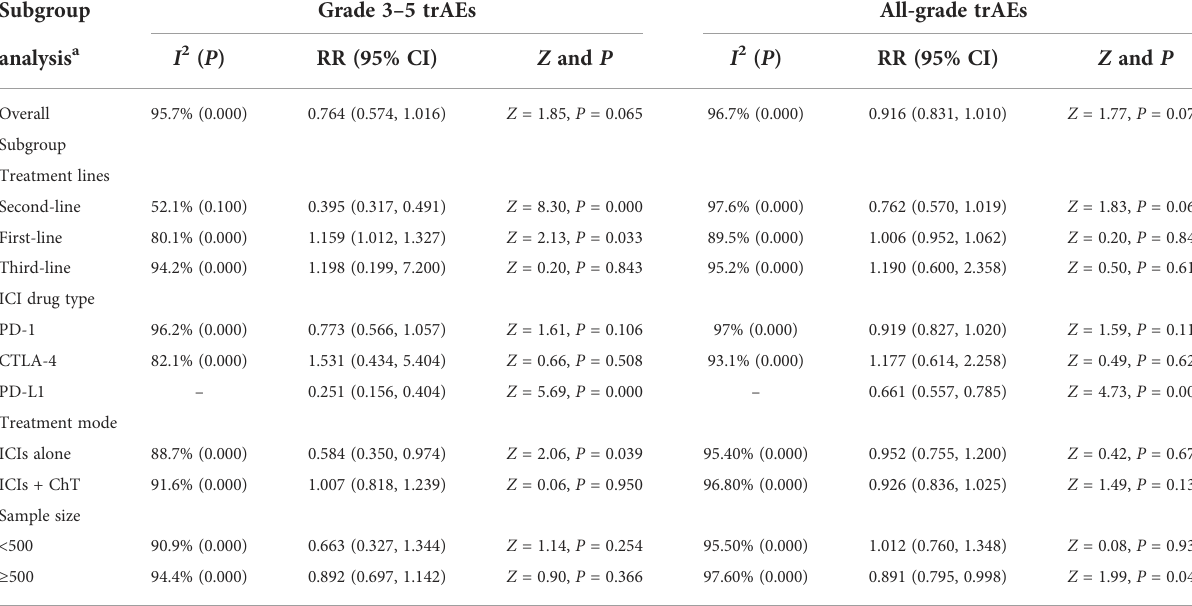
TABLE 2 Subgroup analysis of risk ratios for treatment-related adverse events (trAEs) comparing ICI therapy with chemotherapy.